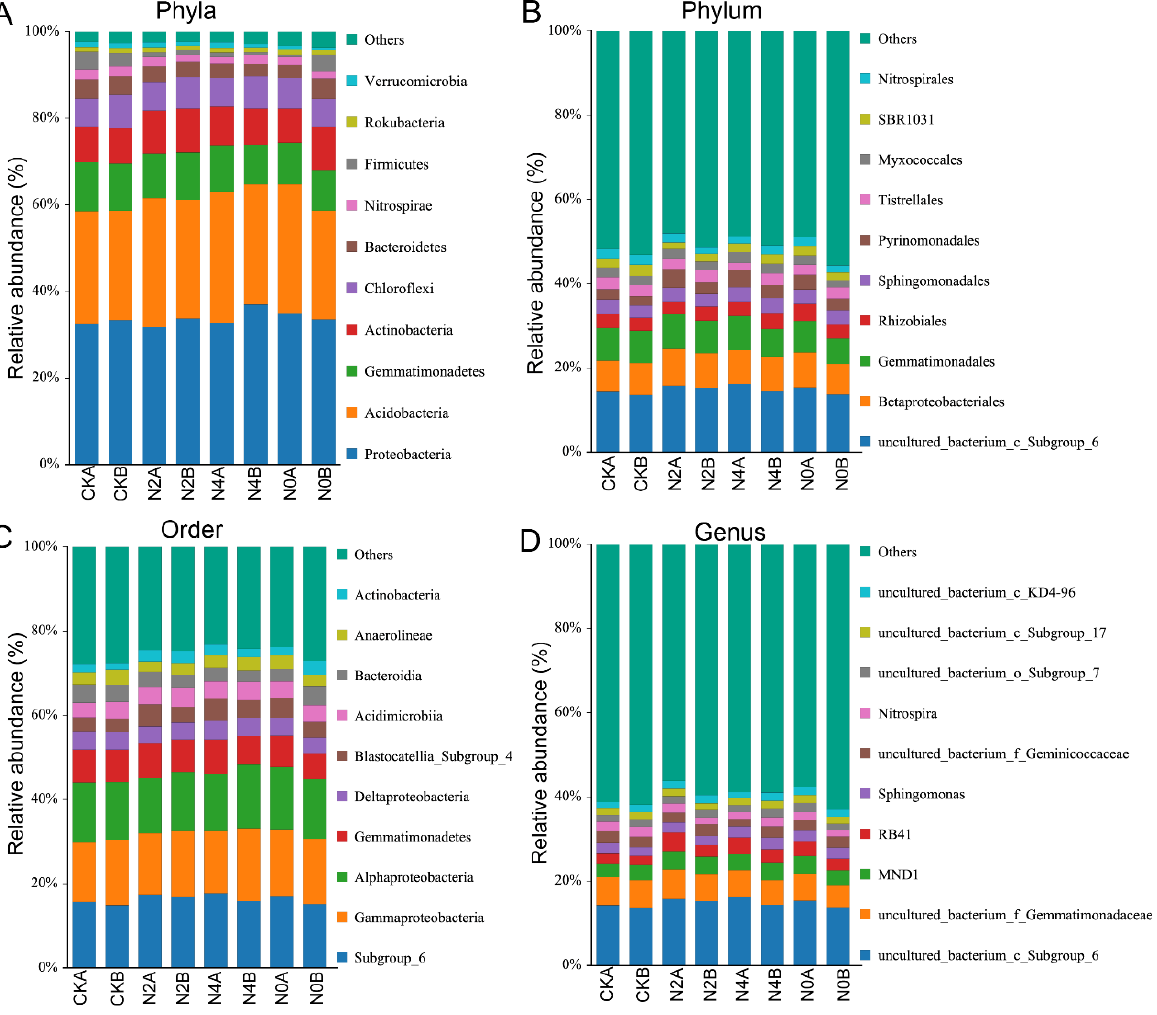
Figure 7. Relative abundance of dominant bacteria at different taxonomic levels. The horizontal axis represents different samples. The vertical axis represents the relative abundance. ( A ) Phyla level. ( B ) Phylum level. ( C ) Order level. ( D ) Genus level.